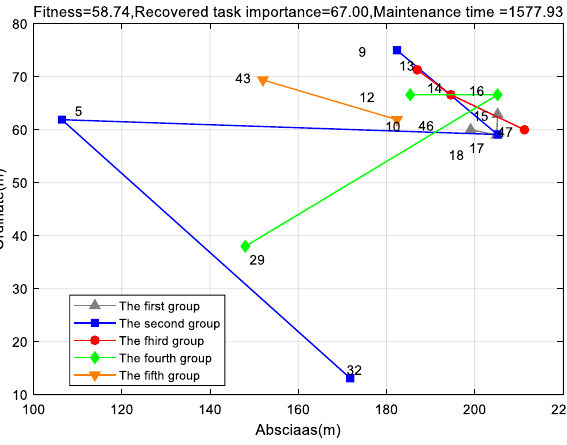
Fig. 13 Recovery strategy of multi-chromosome genetic algorithm on improved quotient model